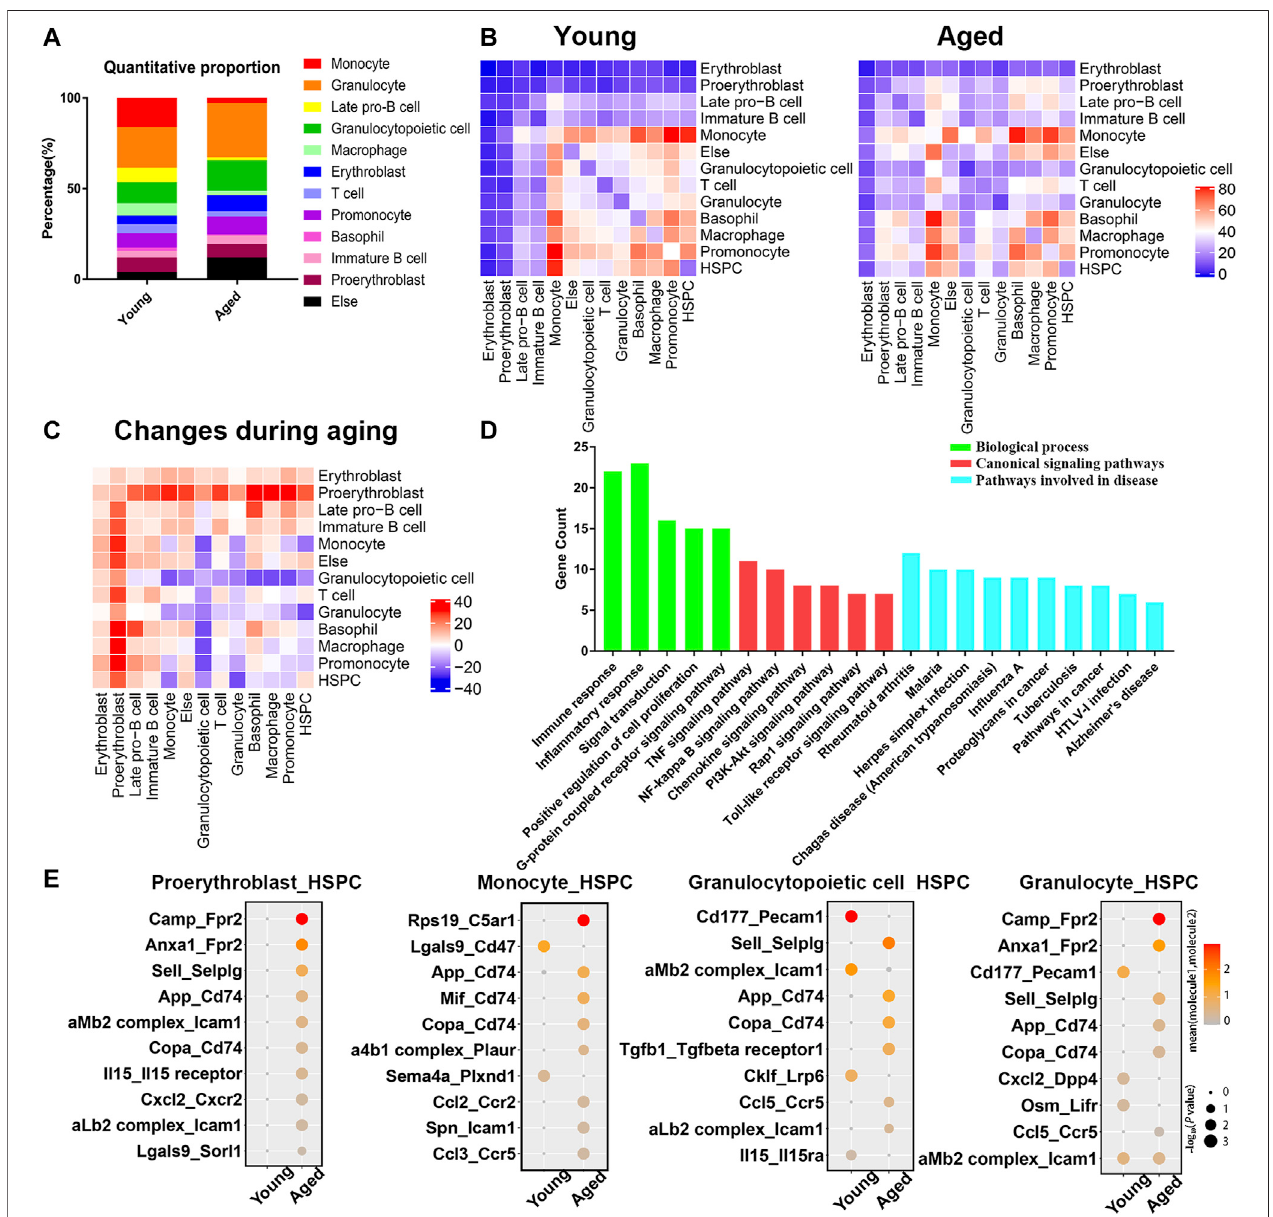
FIGURE5| CellularcompositionandinteractionsbetweenHSCsandothercelltypesinthebonemarrowniche. (A) Quantitativeproportionsofdifferentcelltypesin thebonemarrowniche. (B) Heatmapshowingthenumberofinteractionsbetweendifferentcelltypesinyoungandagedbonemarrowseparately. (C) Heatmapshowing the differences in the number of interactions (interaction number of aged cells minus the interaction number of young cells). (D) Functional enrichment results for differentially expressed ligand – receptor pairs. (E) Dot plots showing the ligand – receptor pairs between the ligand of proerythroblasts/monocytes/ granulocytopoietic cells/granulocytes and the receptor of HSPCs in young and aged mice. The color of the dots represents the mean expression of each ligand and receptor, and the size of the dots represents − log10 ( p